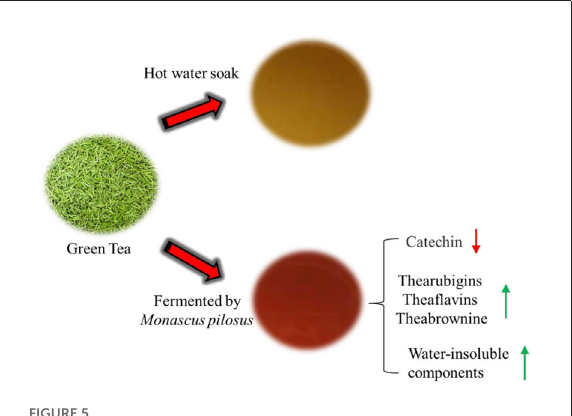
FIGURE5 The color change of tea soup before and after fermentation of Green